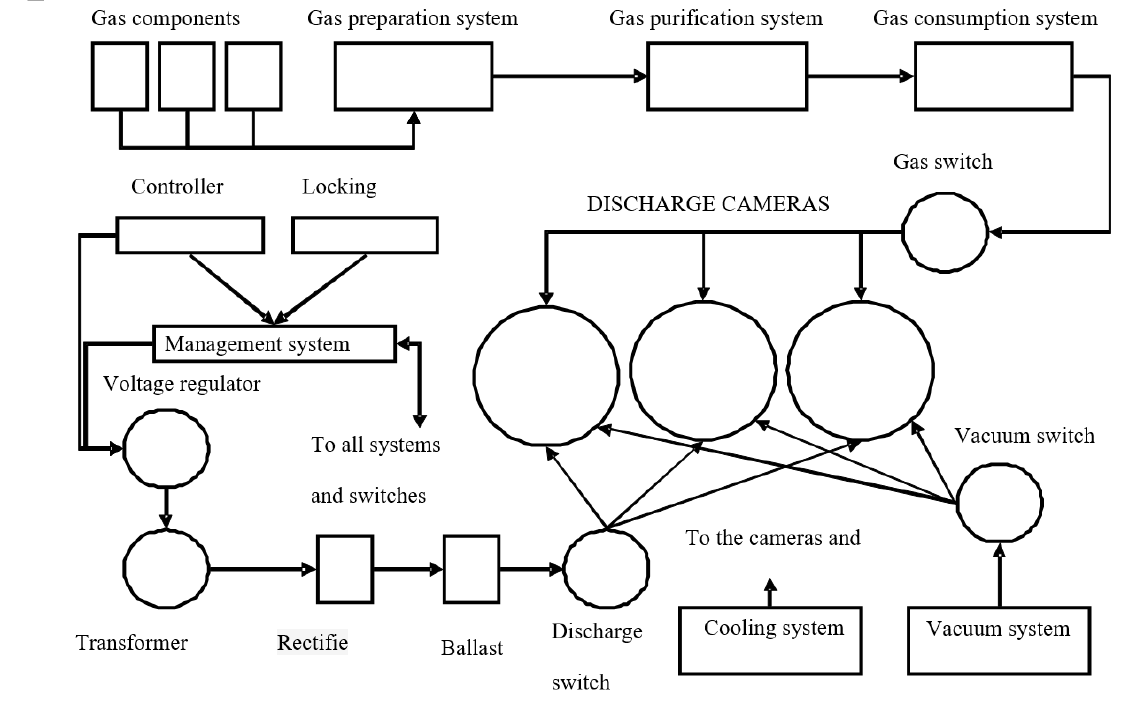
Fig. 1. Block diagram of a three-chamber